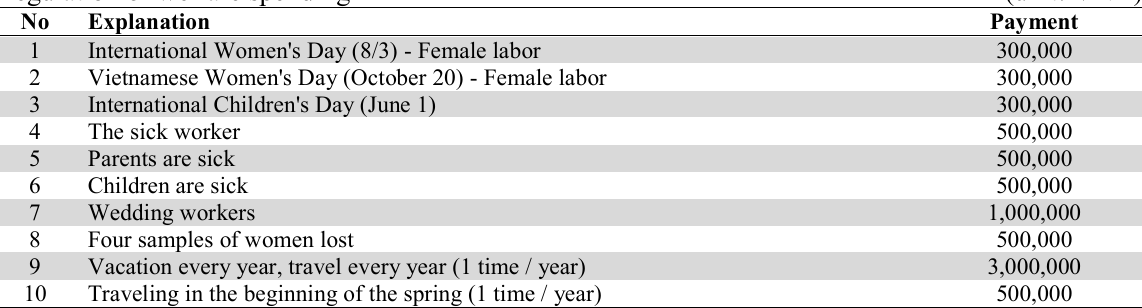
Regulation of welfare spending (unit: